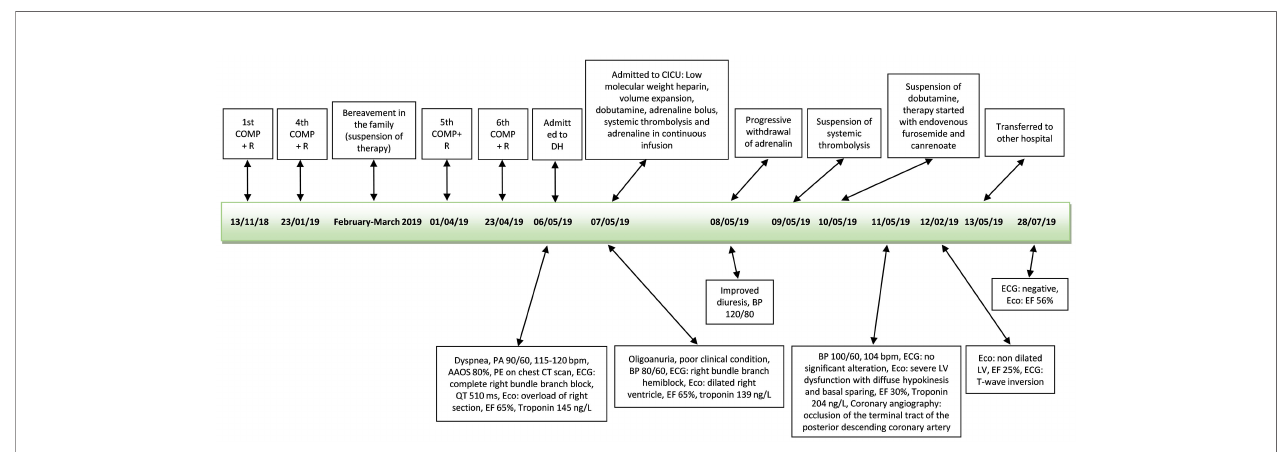
FIGURE 4 | Time line second patient. COMP+R , vincristine, liposomal doxorubicin, cyclophosphamide+rituximab, AAOS , ambient air oxygen saturation; ECG , electrocardiogram; bpm , beats per minute; EF , ejection fraction; BP , blood pressure; PE , pulmonary embolism; Eco , echocardiograph; DH , Day Hospital; CICU , cardiac intensive care